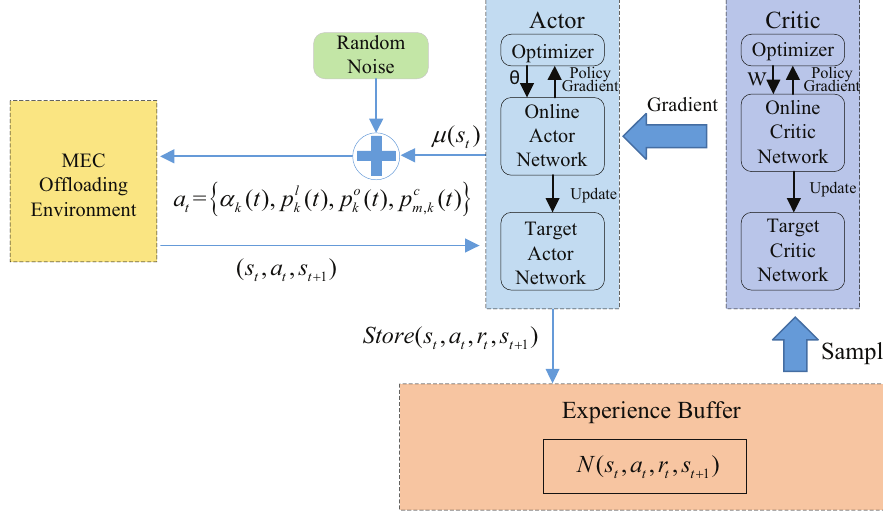
Figure 6. The structure of the DDPG-based offloading